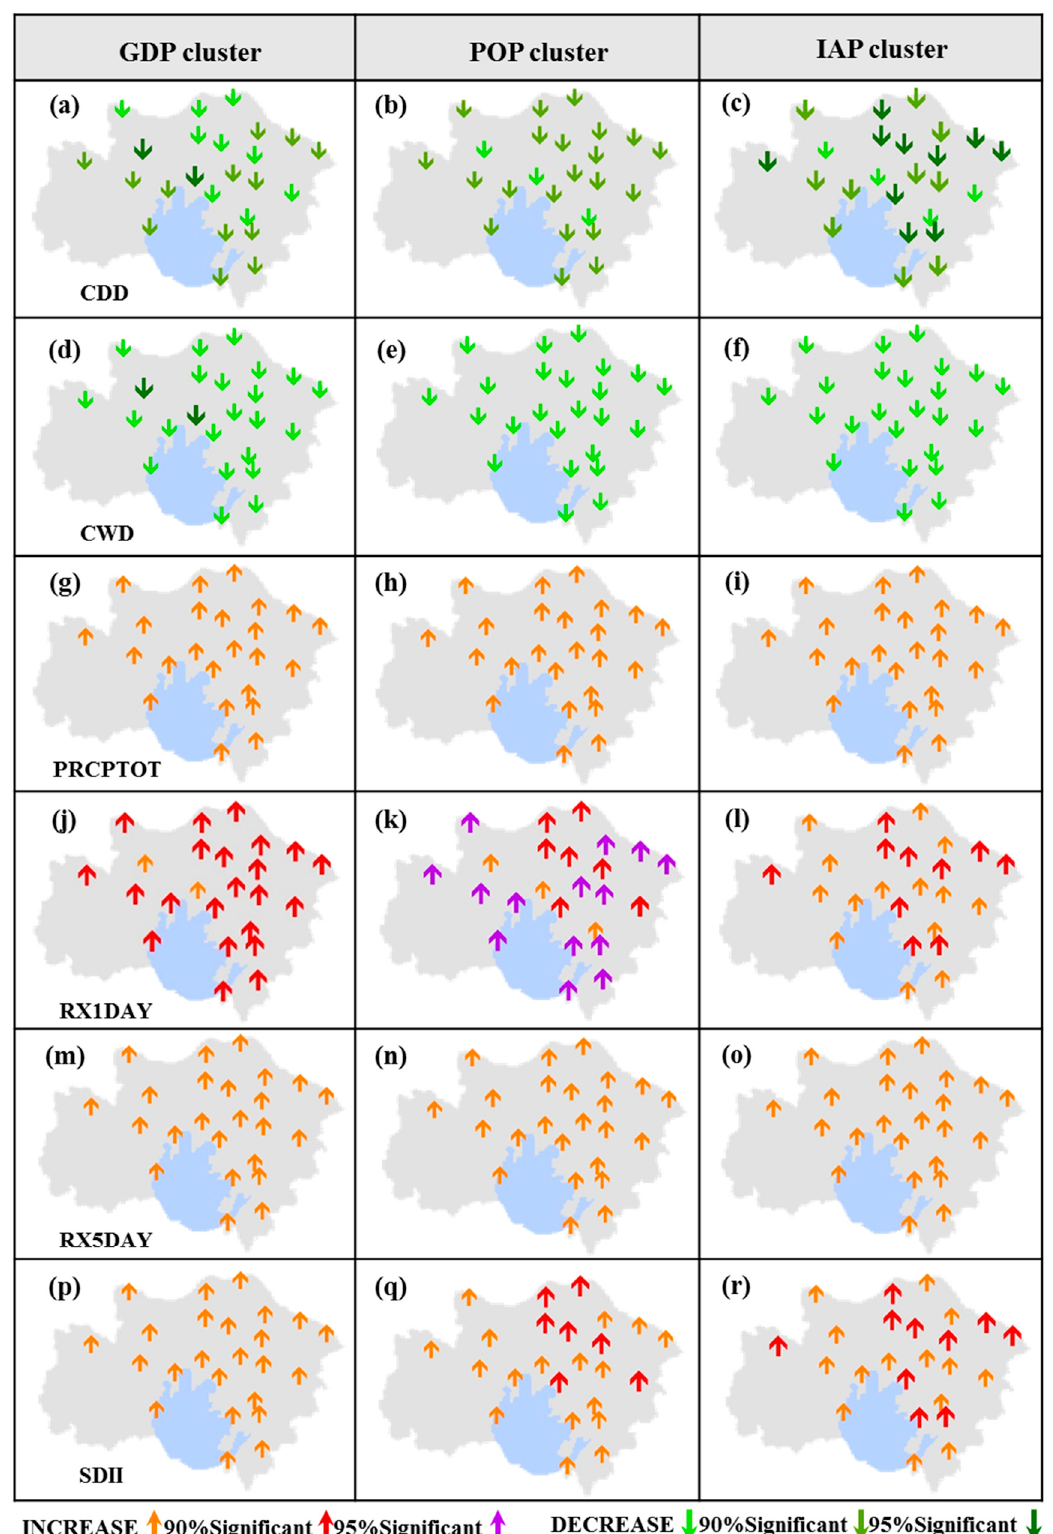
Figure 5. The temporal trends of precipitation extremes for the stations in three urbanized levels during 1980–2015. The results of GDP cluster: CDD ( a ), CWD ( d ), PRCPTOT ( g ), RX1DAY ( j ), RX5DAY ( m ), and SDII ( p ). The results of POP cluster: CDD ( b ), CWD ( e ), PRCPTOT ( h ), RX1DAY ( k ), RX5DAY ( n ), and SDII ( q ). The results of IAP cluster: CDD ( c ), CWD ( f ), PRCPTOT ( i ), RX1DAY ( l ), RX5DAY ( o ), and SDII ( r ).